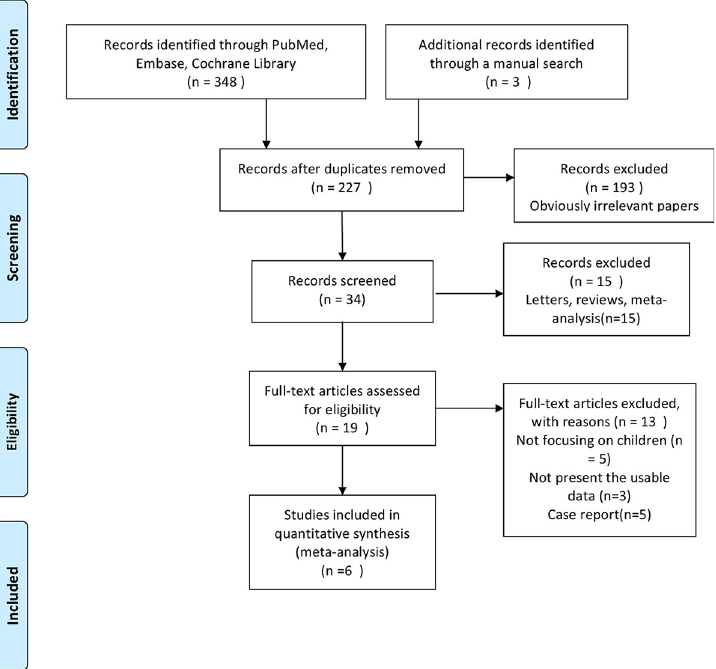
Fig 1. Flow diagram of study